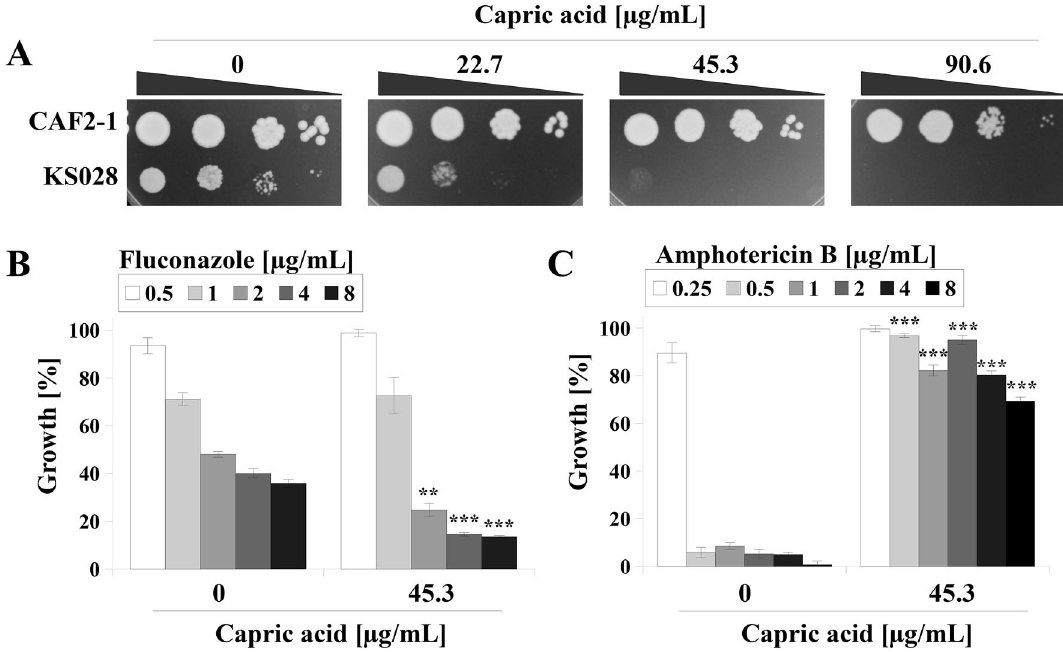
Figure 1. ( A ) Growth phenotypes of C. albicans CAF2-1 (parental strain) and KS028 ( erg11∆/∆ ) strains after 48 h incubation at 28 °C in YPD medium with capric acid (0–90.6 µg/mL). ( B ) Percentage of growth of the C. albicans CAF2-1 strain in the presence of fluconazole (0.5–8 μg/mL, chart legend) and in presence of 45.3 μg/ mL capric acid (means ± SD, n = 3). ( C ) Percentage of growth of the C. albicans CAF2-1 strain in the presence of amphotericin B (0.25–8 μg/mL, chart legend) and in presence of 45.3 μg/mL capric acid (means ± SD, n = 3). Statistical analyses were performed by comparing growth at the same fluconazole ( B ) or amphotericin B ( C